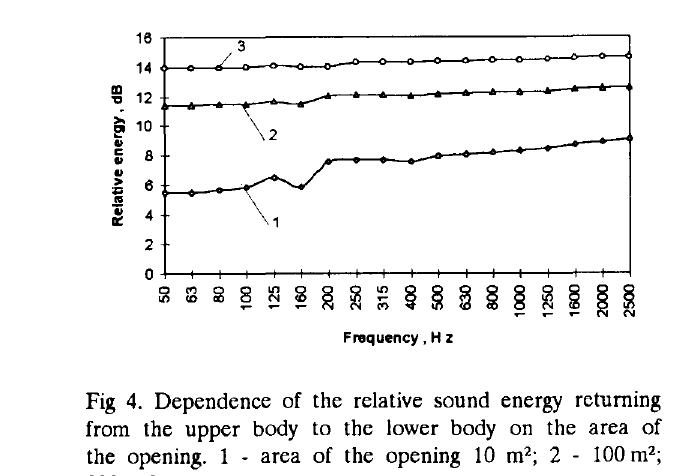
Fig 4. Dependence of the relative sound energy returning from the upper body to the lower body on the area of the opening. 1 - area of the opening 10 m 2; 2 - 100m 2 ; 200 m 2